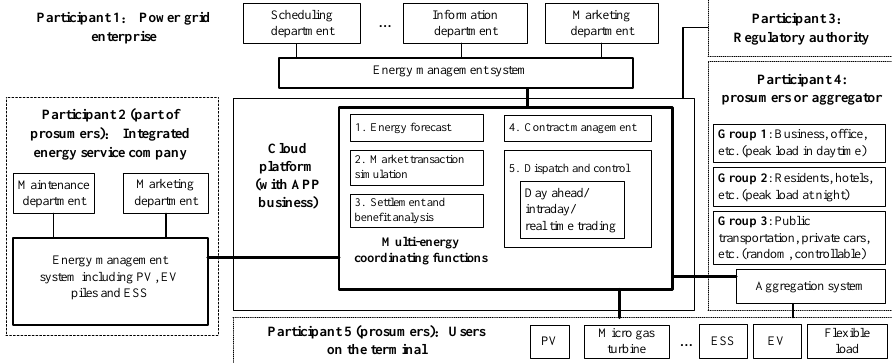
Figure 1. The relational architecture of cloud platform participants.